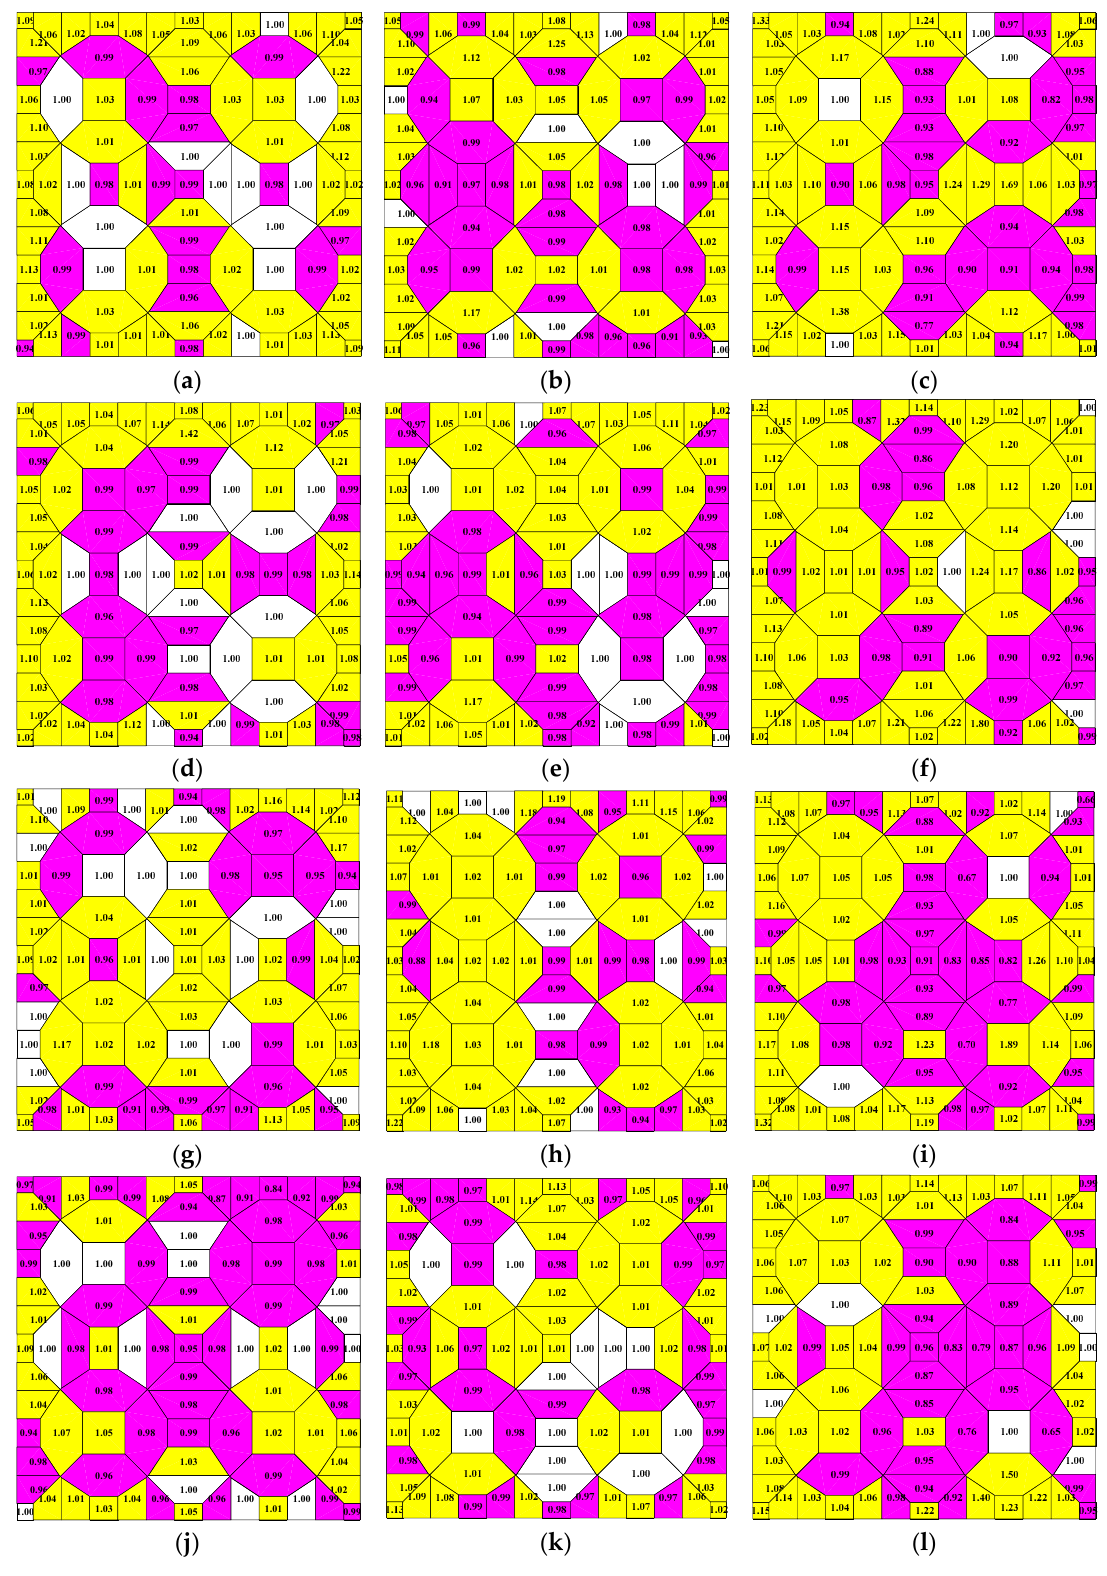
(cid:2246) (cid:2185)(cid:2198) µ cp Figure 6. Ratio distribution on the roofs, model 1 α = 0° ( a ), α = 45° ( b ), and α = 90° ( c ); model 2 α Figure 6. Ratio distribution on the roofs, model 1 α = 0 ◦ ( a ), α = 45 ◦ ( b ), and α = 90 ◦ ( c ); v cp (cid:2204) (cid:2185)(cid:2198) model 2 α = 0 ◦ ( d ), α = 45 ◦ ( e ), and α = 90 ◦ ( f ); model 3 α = 0 ◦ ( g ), α = 45 ◦ ( h ), and α = 90 ◦ ( i ); = 0° ( d ), α = 45° ( e ), and α = 90° ( f ); model 3 α = 0° ( g ), α = 45° ( h ), and α = 90° ( i ); model 4 α = 0° ( j ), α model 4 α = 0 ◦ ( j ), α = 45 ◦ ( k ), and α = 90 ◦ ( l = 45° ( k ), and α = 90° ( l ).